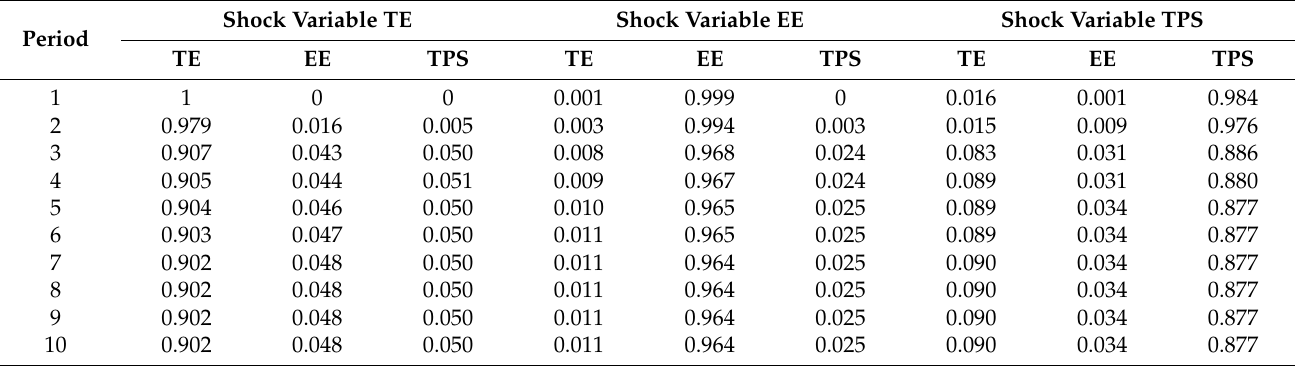
Table 11. Analysis of Variance